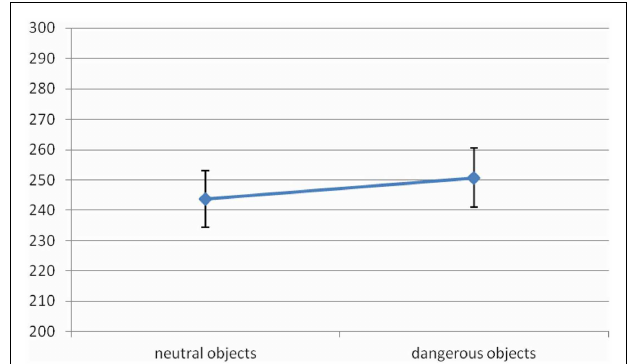
FIGURE 4 | Significant Object Dangerousness effect for RTs in Experiment 2, values are in milliseconds and bars are SEM